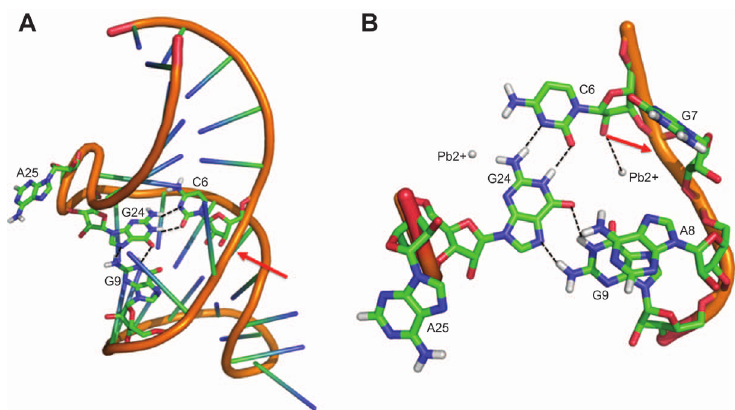
Figure 4 MC-SYM model of leadzyme that is relevant to catalysis. (A) Full structural model. Only C6, G9, and G24 forming the base triple and A25 are shown as stick models. Hydrogen bonds in the base triple are indicated by dashed lines. The red arrow points to the scissile bond. (B) Close view of the base triple and the bulged out A25. Red arrows indicate the in-line attack by the 2 9 -OH of C6 on the adjacent phosphate. Locations of two Pb 2 q ions are represented by gray